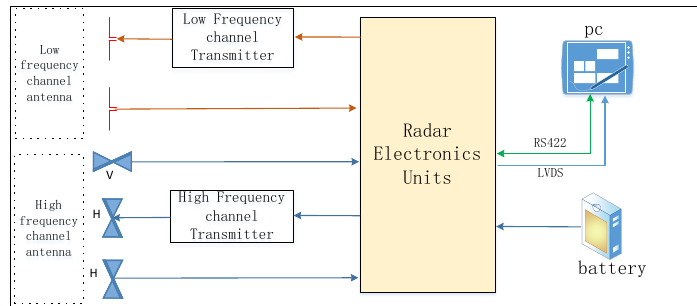
Figure 18. The schematic diagram of the radar device.